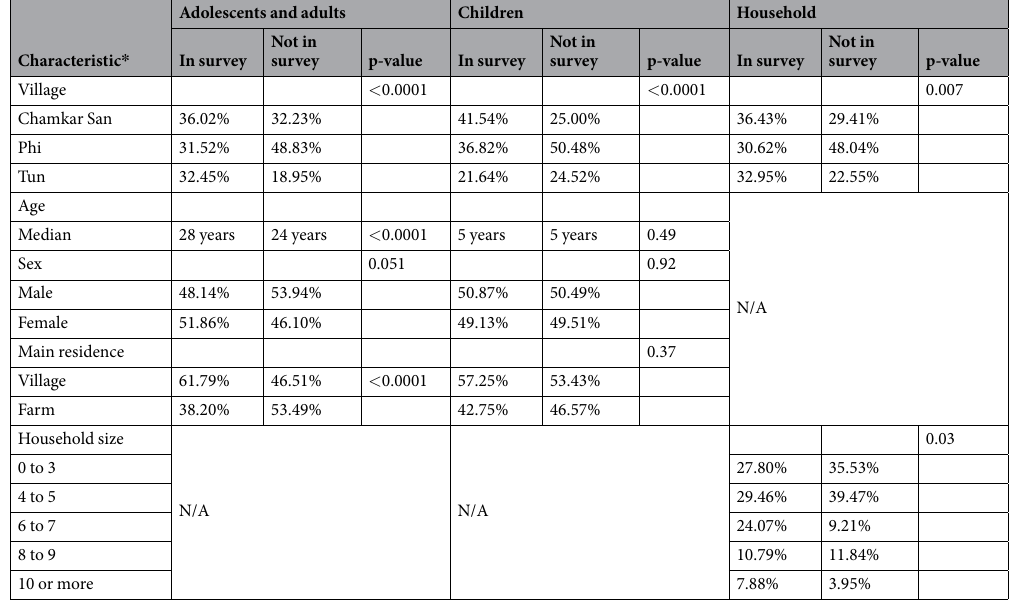
Table 1. Participation in individual and household surveys. * Based on variables collected in 2016 census. p-values calculated chi-squared tests, except for age, for which Mann Whitney test for differences in distributions was used.